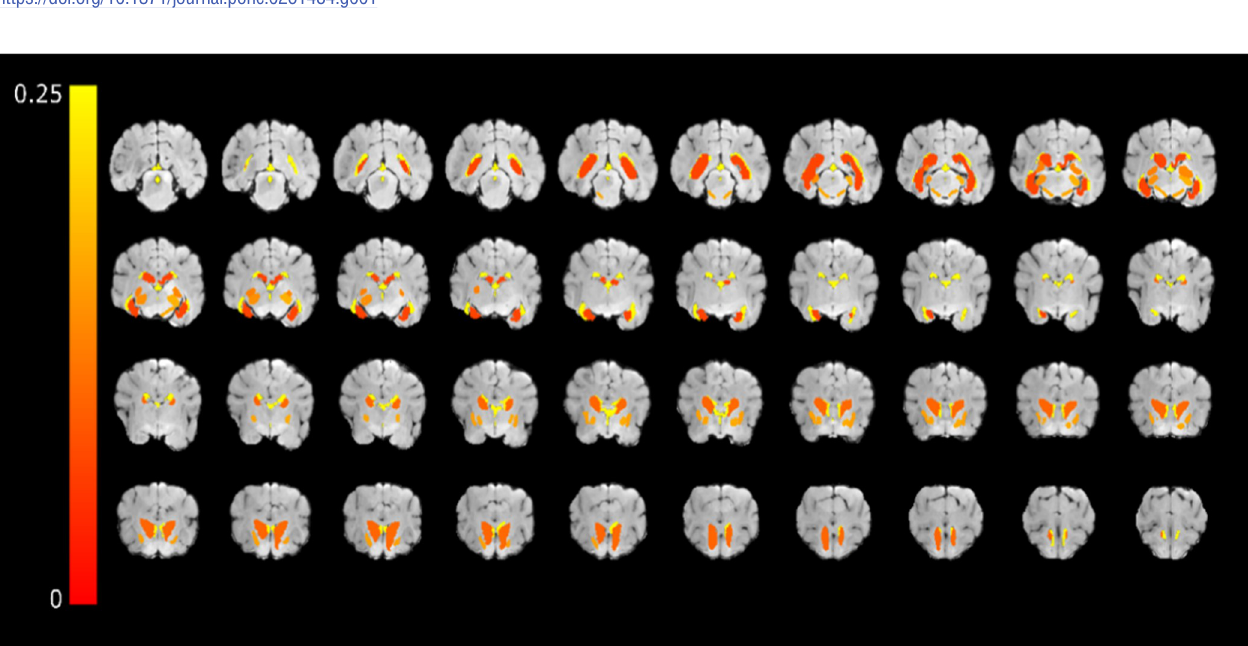
PLOS ONE | https://doi.org/10.1371/journal.pone.0261484 October 7, 2022 7 /